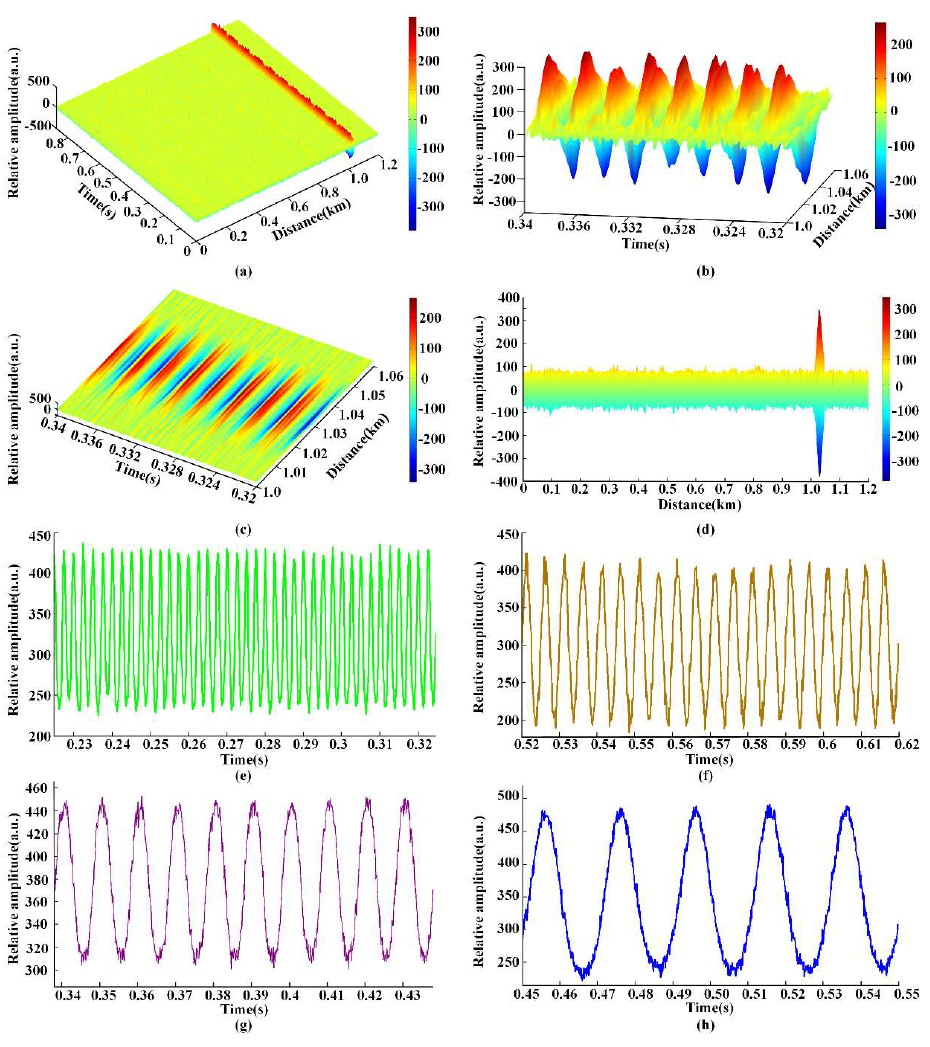
Figure 6. Sine wave signal test: ( a ) 3D plot of the intensity variation under 400 Hz sinusoidal signal; ( b ) partially enlarged view of the intensity variation under 400 Hz sinusoidal signal; ( c ) top view of the intensity change under 400 Hz sinusoidal signal; ( d ) superimposed differential signal under 400 Hz sinusoidal signal; ( e ) extracted vibration waveform under 400 Hz sinusoidal signal; ( f ) extracted vibration waveform under 200 Hz sinusoidal signal;( g ) extracted vibration waveform under 100 Hz sinusoidal signal; ( h ) extracted vibration waveform under 50 Hz sinusoidal signal.